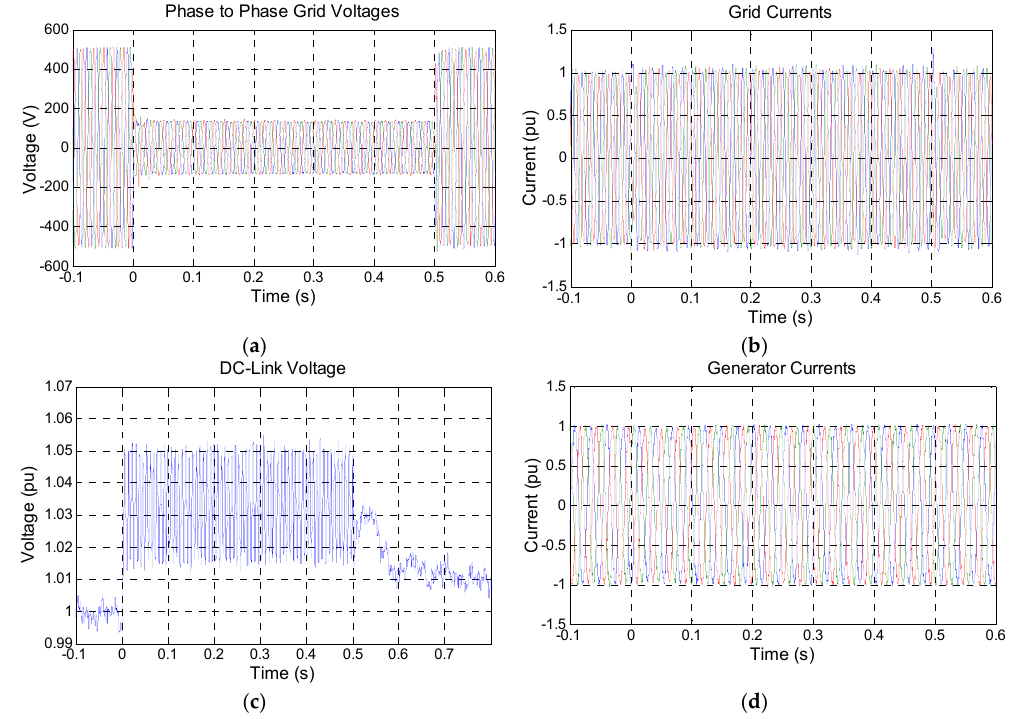
Figure 8. Experimental results for 25% three-phase voltage sag with the system operating with 100% rated power: ( a ) grid voltages; ( b ) grid currents; ( c ) DC ‐ link voltage; and ( d ) generator currents.